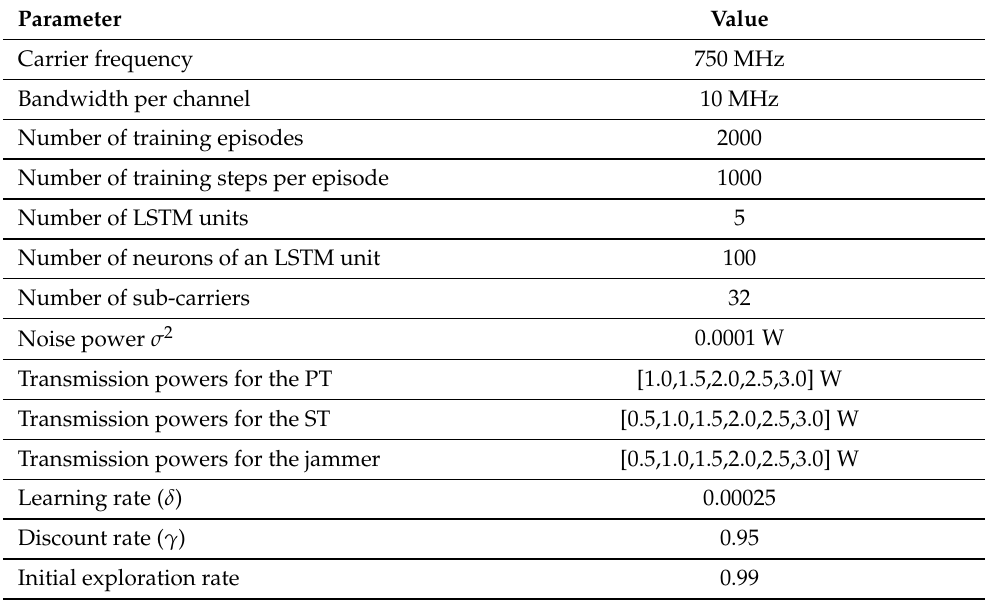
Table 1. Main Simulation Parameters.